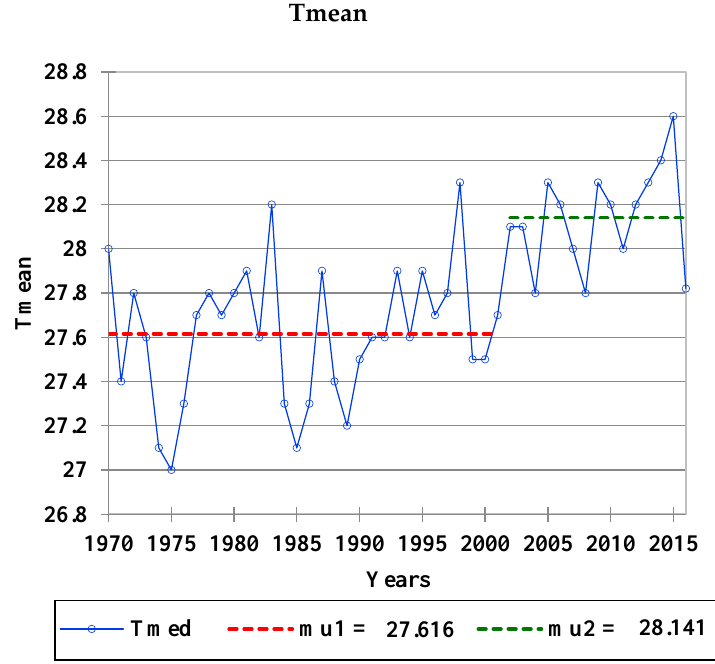
Figure 5. Results of the Buishand test, for the mean temperature (Tmean), expressed in degrees Cel- sius.